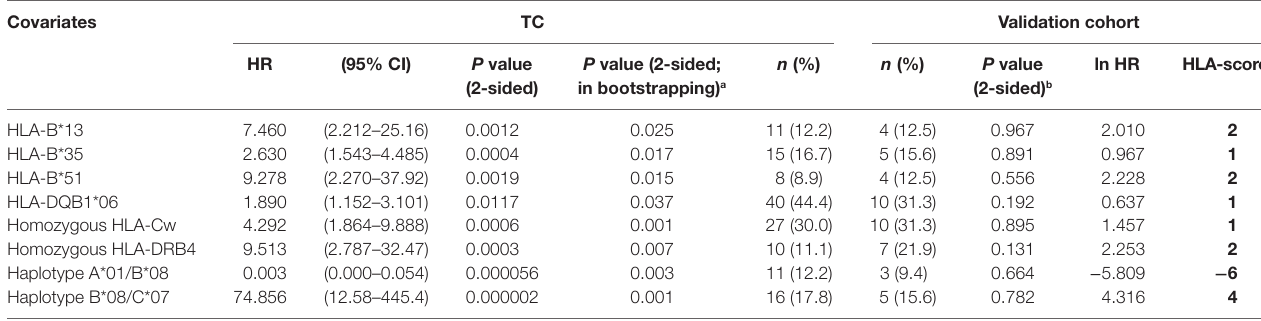
TaBle 2 | Significant independent predictors for progression-free survival of head and neck squamous cell carcinoma patients according to published data from the multivariate Cox regression model (18) used to define the human leukocyte antigen (HLA) score. covariates Tc Validation cohort hr (95% ci) P value P value (2-sided; n (%) n (%) P value ln hr hla-score (2-sided) in bootstrapping) a (2-sided) b HLA-B*13